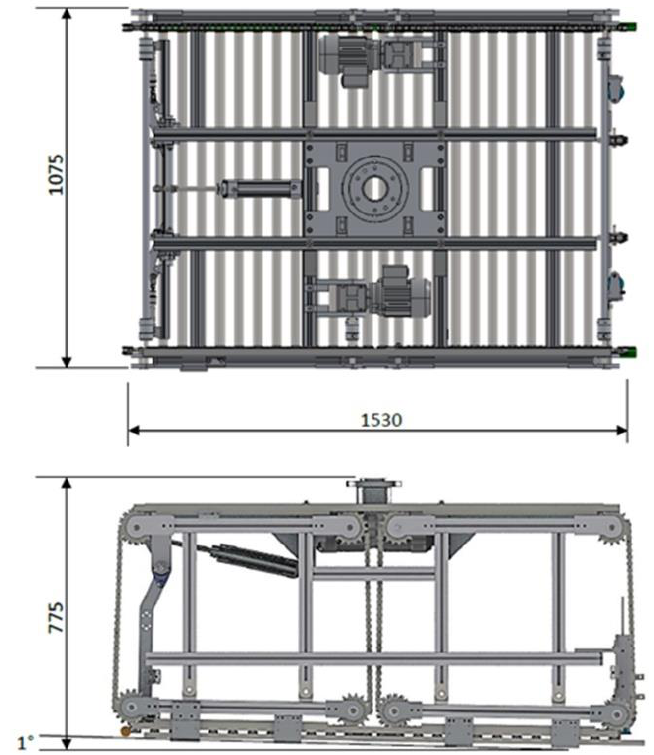
Figure 7. Main dimensions of the designed gripper.